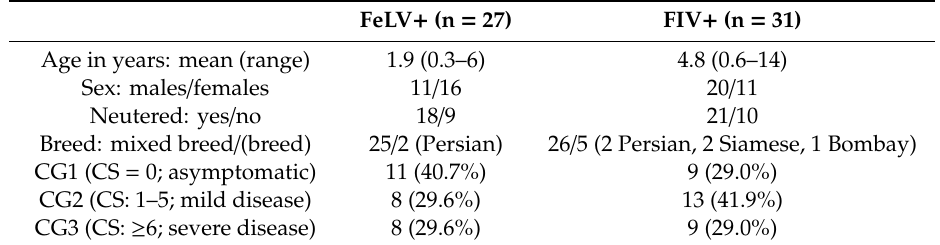
Table 1. Epidemiological data of the cats enrolled in the study and distribution of the clinical groups (CG). CS, clinical score.